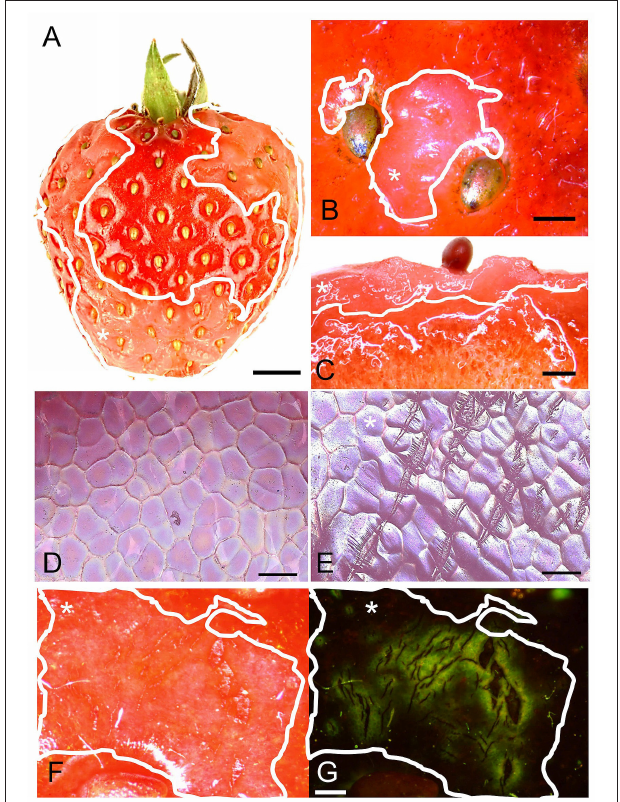
FIGURE 1 | (A) Macroscopic view of fruit with water soaking symptoms; (B) Detail of achenes with surrounding water-soaked area viewed under a light microscope; (C) Micrograph of cross-section of tissue with water soaking. (D,E) Scans of the surface in a digital microscope of non-treated and water-soaked fruit with numerous microcracks. (F,G) Micrographs of developing symptoms of water soaking viewed under incident (F) and fluorescent light (G) . Microcracks were infiltrated with acridine orange. The penetrated fluorescent tracer appears as a green fluorescence around a microcrack in the cuticle. Water soaking symptoms are marked by a solid white line. White asterisks in A , B , C , E , F and G identify the water-soaked area. Scale bar in (A) = 5 mm, (B,C) = 1 mm, (D,E) = 0.1 mm and in (F,G) = 0.5